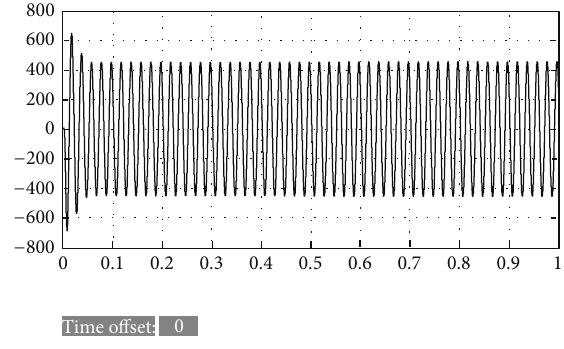
Figure 19: MLI filtered output voltage ( 𝑉 𝑜 ).